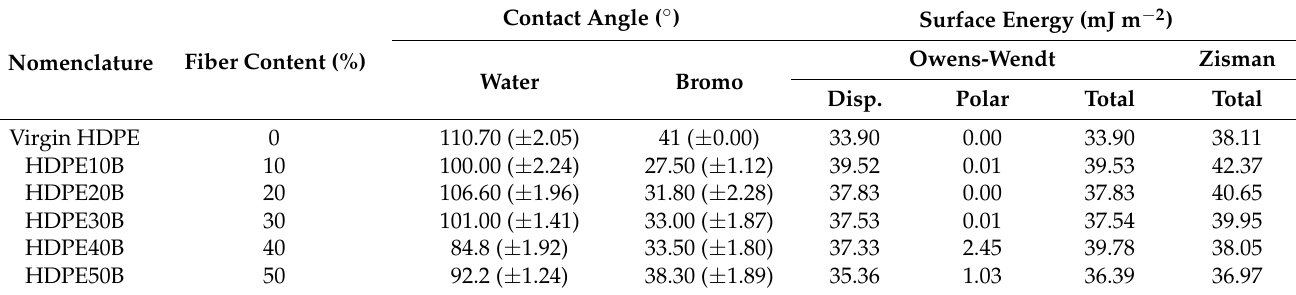
Table 3. Contact angle and surface energy of HDPE/birch